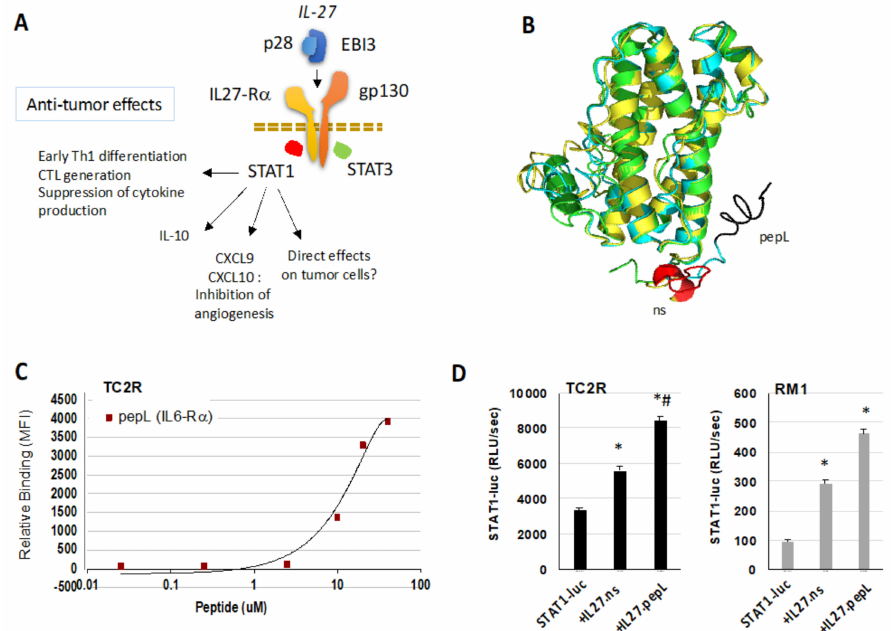
Figure1. IL-27cytokineandpeptidecharacterization. ( A )SignalingswitchestowardsSignaltransducers and activators of transcription 1 (STAT1) in IL-27-stimulated cells, promoting anti-tumor e ff ects in the tumor microenvironment. The e ff ects of IL-27 directly on tumor cells are not as well-characterized as on immune cells. ( B ) The IL-27p28 subunit was modeled with one linker and peptides (nonspecific (ns), or LSLITRL (PepL)) appended at the C-terminus via genetic modification. These modified p28s showed a high degree of homology. ( C ) TRAMPC2-Ras (TC2R) cell binding assay for a concentration range of PepL conjugated to fluorescein isothiocyanate (FITC) and assessed by flow cytometry; MFI, mean fluorescence intensity. ( D ) STAT1-luciferase (luc) reporter assays for TC2R and Ras / myc (RM1) cell lines, showing that cotransfection with an IL-27ns plasmid enhanced STAT1 activity (* p < 0.05 relative to baseline) and cotransfection with a IL-27pepL plasmid enhanced STAT1 activity further (# p < 0.05 relative to